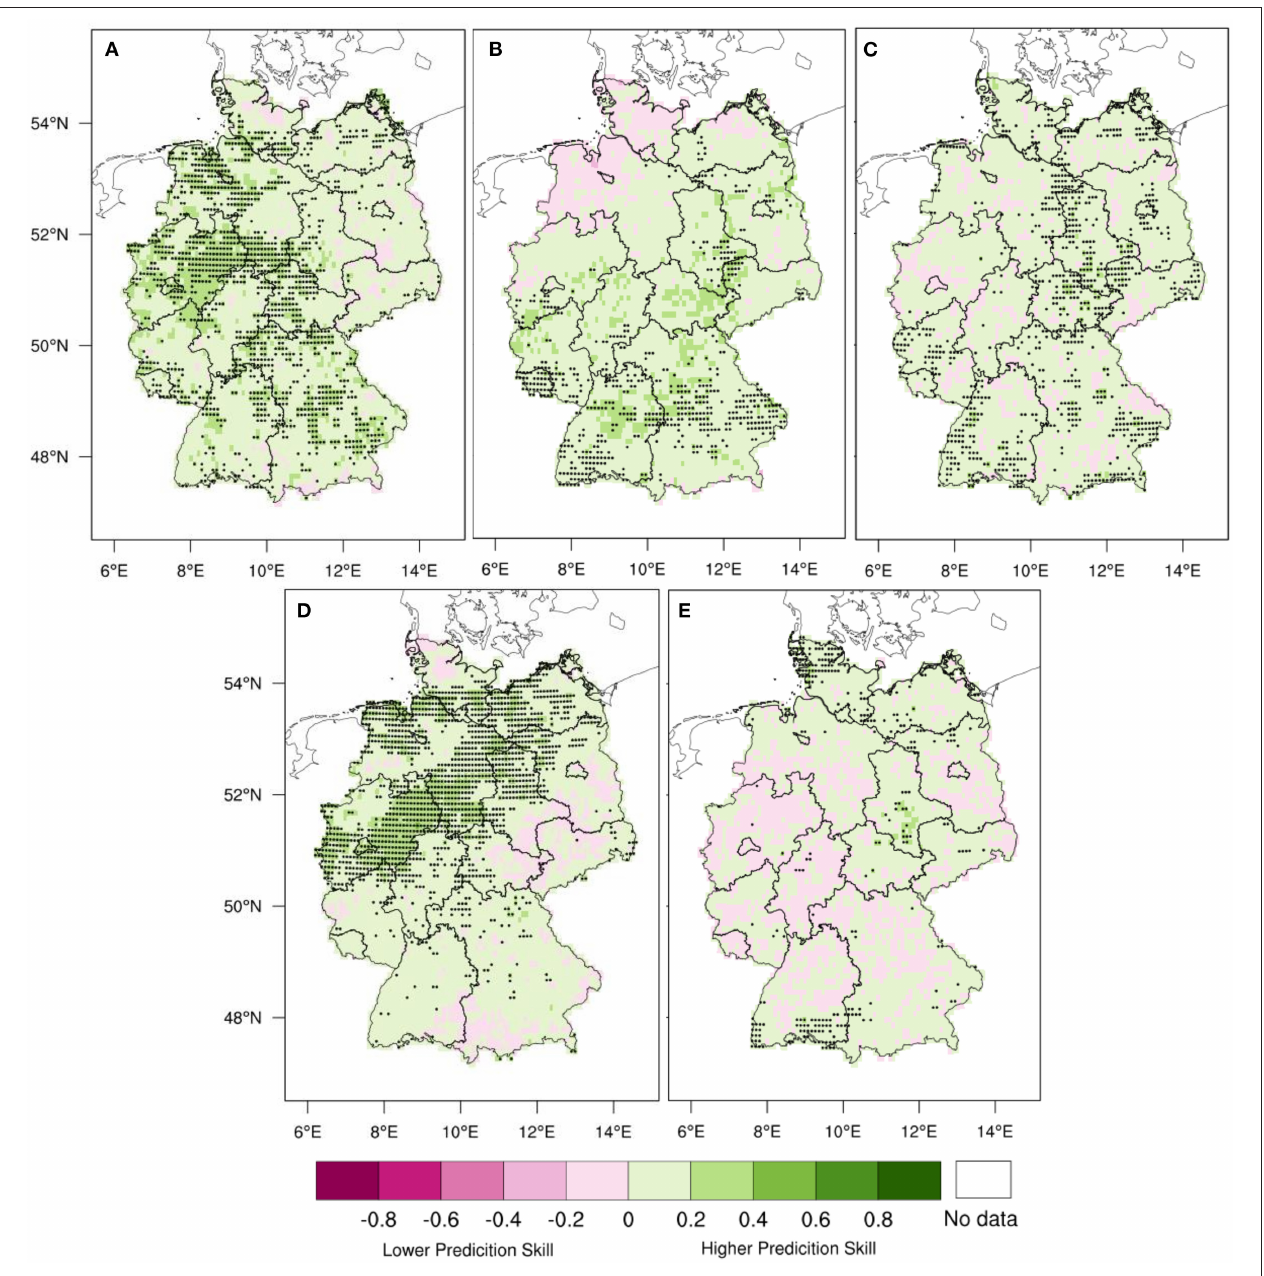
FIGURE 6 | Decadal prediction skill for 3-year SPI of January–December (A) , February–April (B) , May–July (C) , August–October (D) and November–January means (E) for forecast years 1–3 in the evaluation period 1962–2020 (1962–2019 for November–January): FairRPSS of EPISODES at optimized recalibration compared to the observed HYRAS climatology as reference prediction. Dots indicate significant skill (significance level of